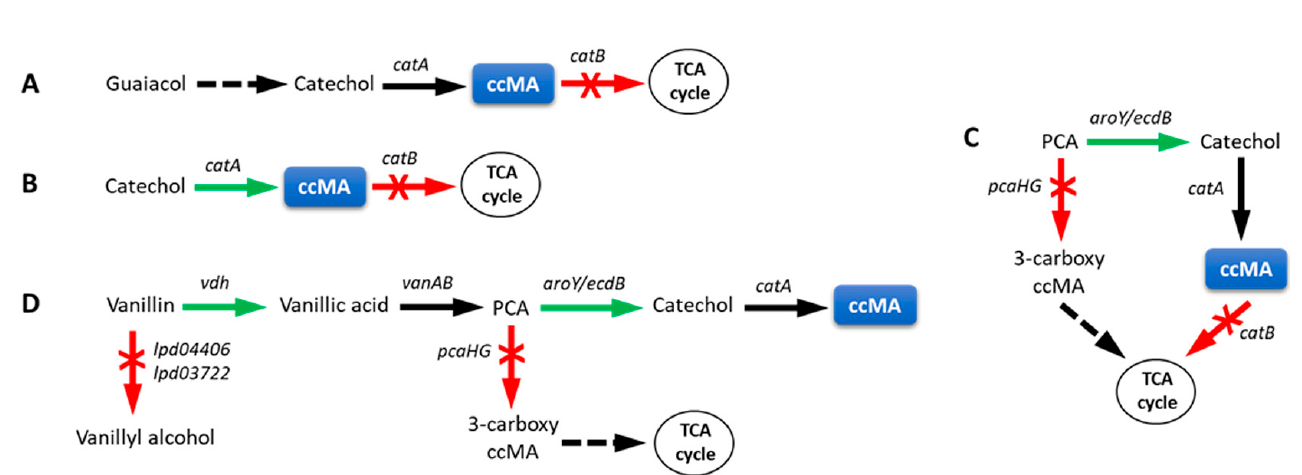
(CatB) involved in the β -ketoadipate pathway, the MA-2 mutant strain was generated (Figure 3A): the optimized engineered strain produces 3.1 g/L ccMA from guaiacol after 24 h incubation, with a 96% yield, when cultivated at 37 °C in a fed-batch process using a